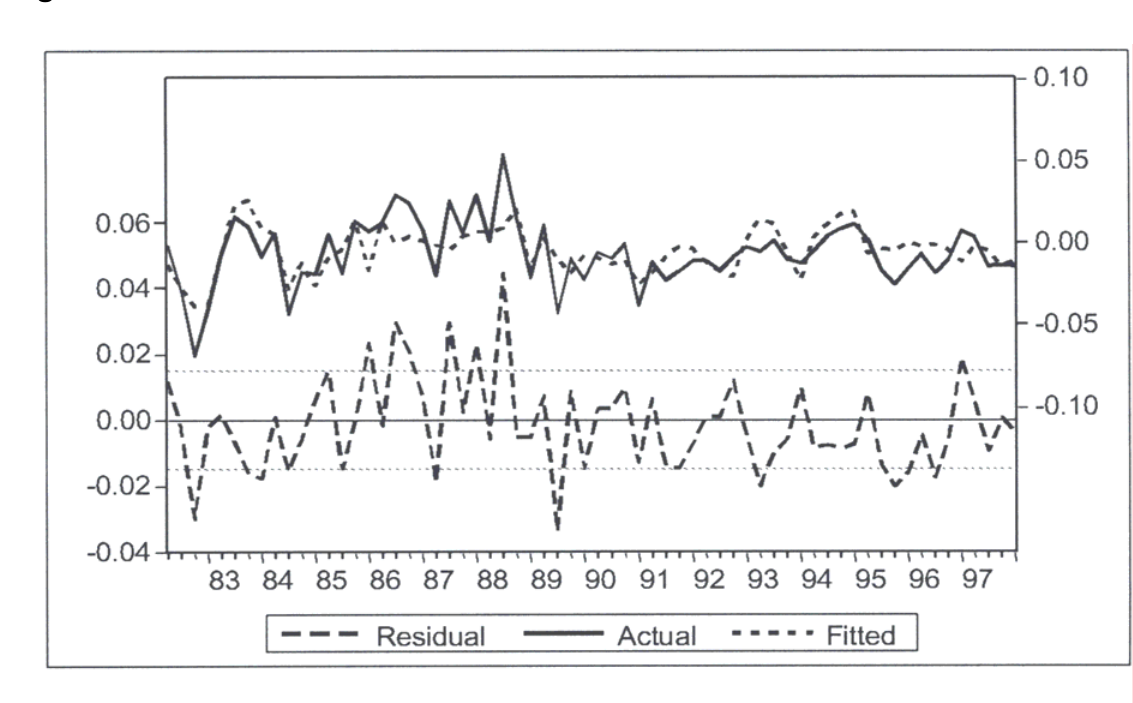
Goodness-of-fit